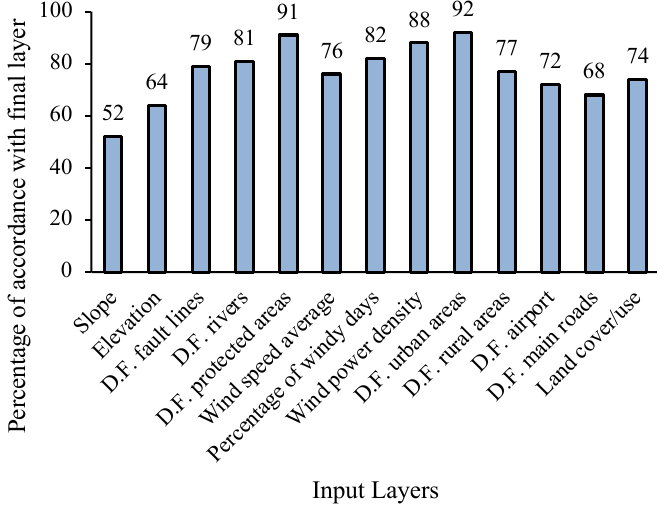
Figure 8 . Sensitivity analysis results for fuzzy